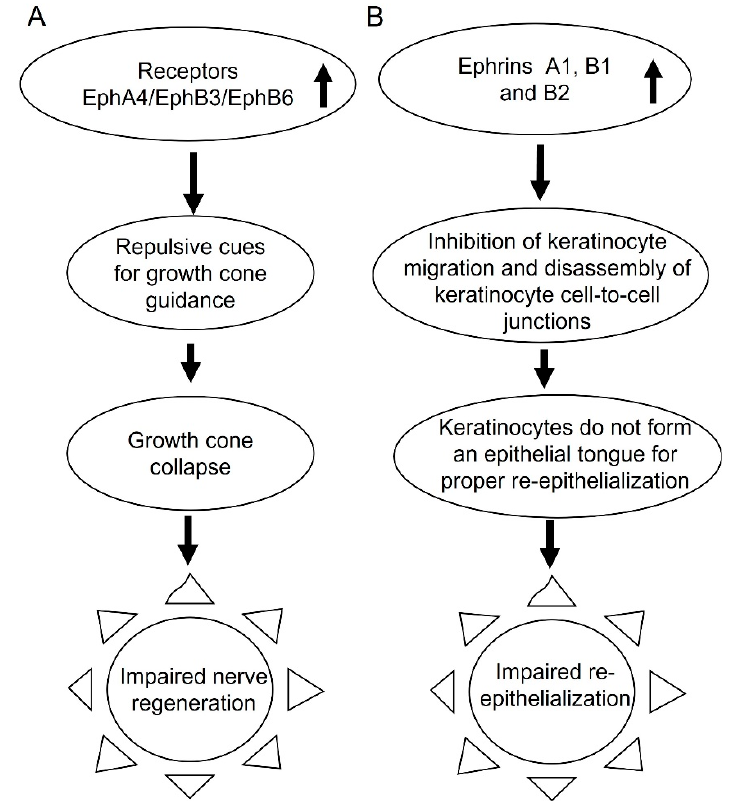
Figure 3. Ephrin signaling is dysregulated during early chronicity. Ephrin signaling has many repercussions when dysregulated. ( A ) Overexpression of Eph receptor A4, B3, and B6 results in repulsive cues leading to growth cone collapse. This hinders healing of motor and sensory neurons after injury in chronic wounds and causes impaired nerve regeneration. ( B ) Overexpression of Ephrin A1, B1, and B2 inhibits keratinocyte migration and causes dissolution of cell-to-cell junctions. This results in individual keratinocyte cells not forming an epithelial tong and wandering into the wound bed failing to re-epithelialize.